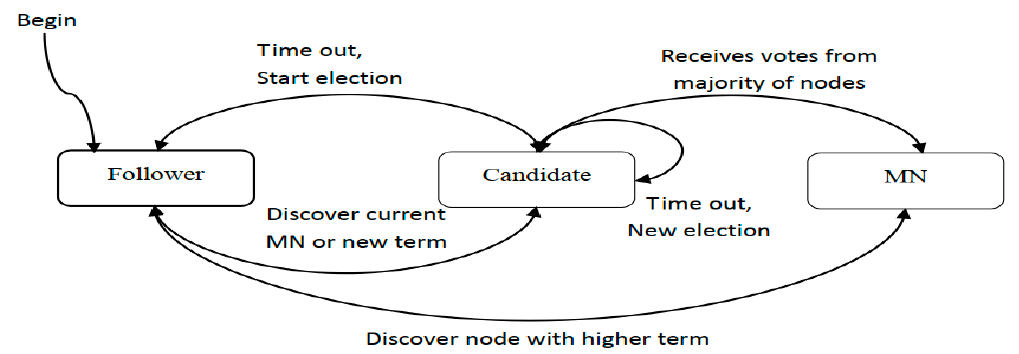
Figure 2. State transition model of MN election algorithm.